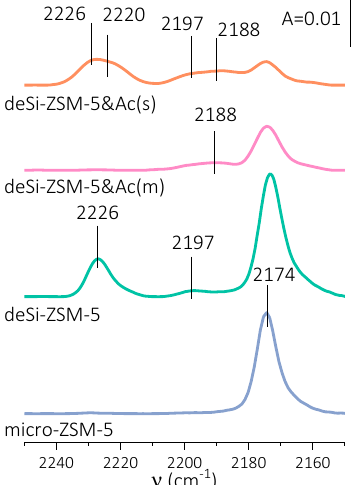
Figure 3. FT-IR spectra of CO sorbed at − 100 °C onto zeolites after full saturation of Lewis acid sites, (for clarity, only spectra without full saturation of Brønsted acid sites are presented).